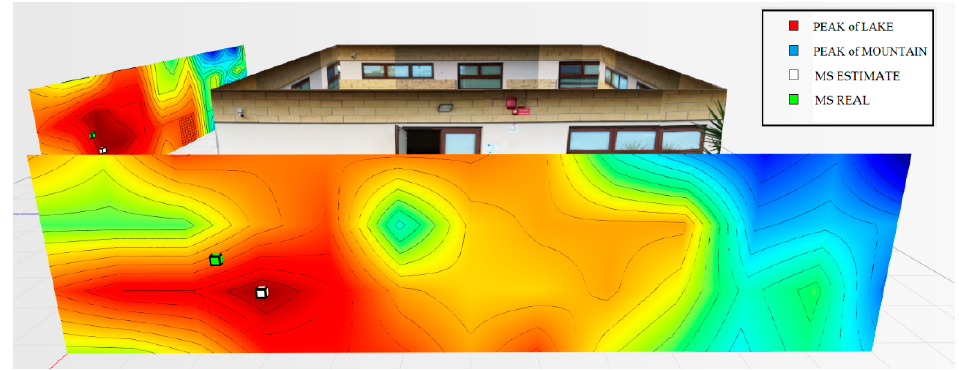
Figure 26. Power levels for wall 2 relative to the terminal located in the room on the left at 1.5 m with the filter.